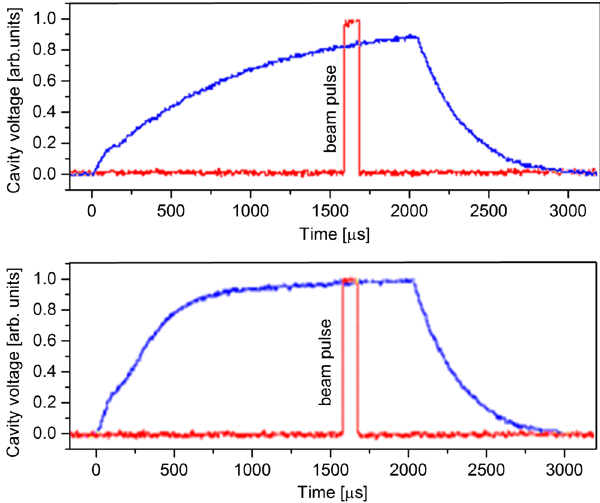
FIG. 8. Shape of the cavity voltage before (top) and after (bottom) optimization.